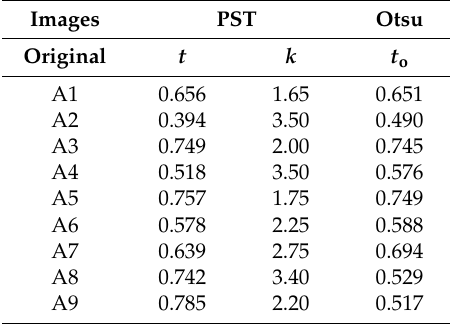
Table 2. Thresholding